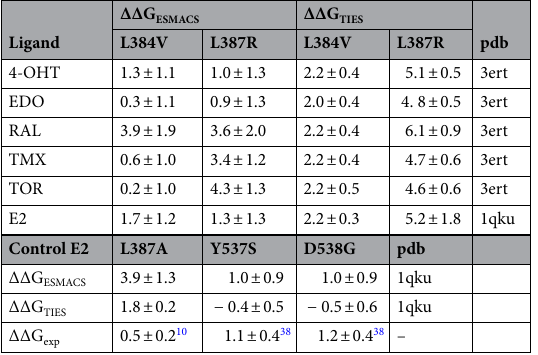
Table 2. Relative binding free energies (cid:31)(cid:31) G = (cid:31) G mut binding − (cid:31) G WT binding for six ligands with two ER mutations—L384V and L387R—from ESMACS and TIES approaches. The calculations for the three mutations taken from the literature—L387A, Y537S and D538G—are presented as a control. The Poisson-Boltzmann (PB) free energy methods were used in the predictions of the ESMACS free energies, while alchemical approach was used for TIES. All energy values are in